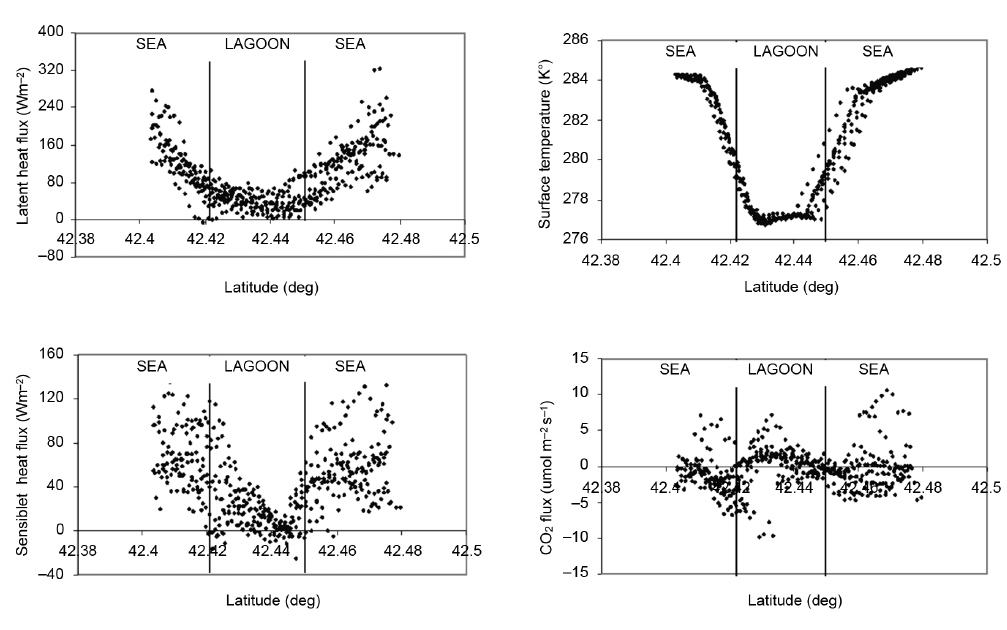
Fig. 3. Sensible heat, latent heat, CO 2 fluxes and surface temperature measured over fresh water and marine surfaces, plotted against latitude. Track direction was North-South. Each point is a flux computed over a 2500 m length path, or, for surface temperature, the average value of the same path. Ten passages over the path are re- ported. Vertical bars mark the delimitation between marine and lagoon